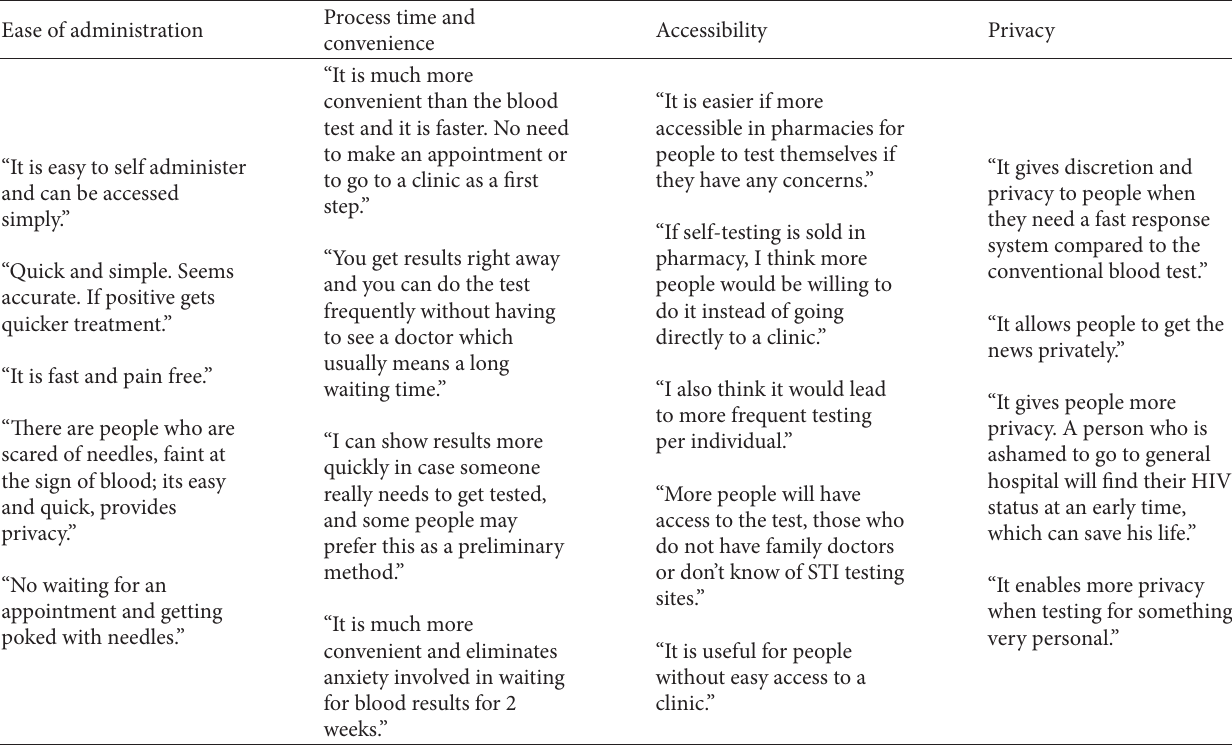
Table 3: Select reasons expressed by participants for why self-testing should be made available ∗ ( 𝑁 = 145